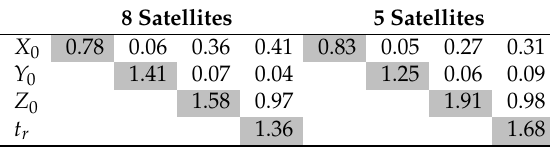
from all available 8, and 5 satellite pseudorange observations. P ˆ P